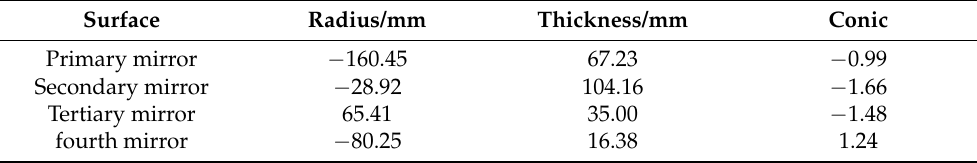
Figure 6. The schematic diagram of the initial structure of the four-reflection optical system. Table 3. Initial parameters of the rear polarization system.